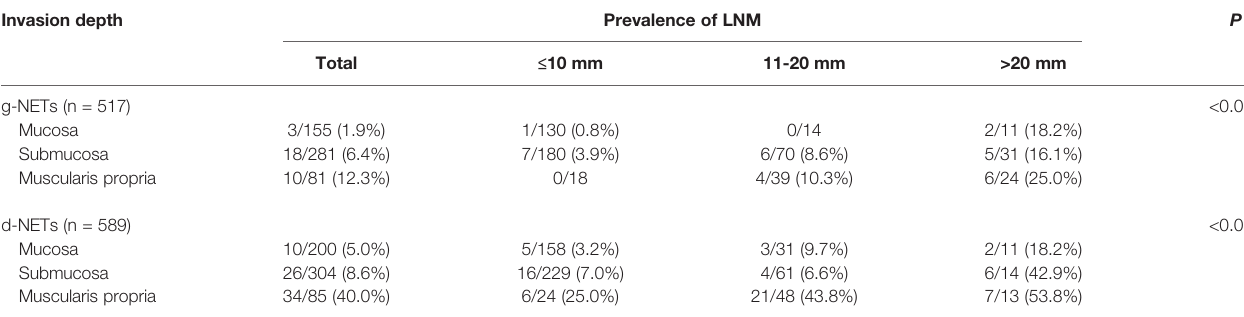
TABLE 5 | Association of invasion depth, tumor size, and LNM in 1106 patients with gastroduodenal NETs. Invasion depth